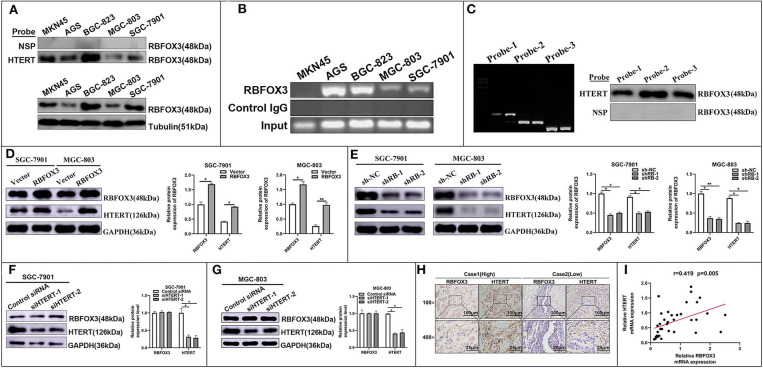
RBFOX3 functioned as a HTERT promoter binding protein in gastric cancer (GC) cells. (A) We detected the binding of RBFOX3 on the 5′-biotin-labeled HT ERT promoter probe or a non-specific probe (NSP) via Western blot using anti-RBFOX3 antibody. We detected RBFOX3 protein in the cytoplasm protein-HTERT probe-streptavidin bead complexes in MKN45, AGS, SGC-7901, MGC-803, and MGC-823 cells (upper panel). We analyzed the expression of total RBFOX3 proteins in GC cells using Western blot and utilized tubulin as a loading control (lower panel). (B) Chromatin immunoprecipitation assays were conducted in GC cells using RBFOX3 antibody and HTERT promoter primers. We separated the PCR products on 2% agarose gels. We used IgG as a negative control. (C) We incubated the 5′-biotin-labeled probes corresponding to the diverse fragments of HTERT promoter (probes 1–3, left panel) or a non-specific probe with MGC-803 cell lysates and streptavidin beads. Western blot results using anti-RBFOX3 antibody (right panel) show the detection of the protein-bound proteins. (D,E) HTERT protein expression was down-regulated in RBFOX3-silenced SGC-7901 as well as MGC-803 cells and up-regulated in RBFOX3 overexpressing SGC-7901 and MGC-803 cells. (F,G) RBFOX3 protein expression was not affect in HTERT-silenced SGC-7901 as well as MGC-803 cells. (H) Immuno-histochemical results of RBFOX3 and HTERT protein levels from GC tissues represented by two images. “Low” denotes the low expression of both RBFOX3 and HTERT and “High” denotes the high protein expression of both RBFOX3 and HTERT. (I) Association between the expressions of RBFOX3 and HTERT in 37 GC paraffin section samples from GC tissues. Pearson correlation test, n = 37, r = 0.419, p = 0.005. *p < 0.05, **p < 0.01.